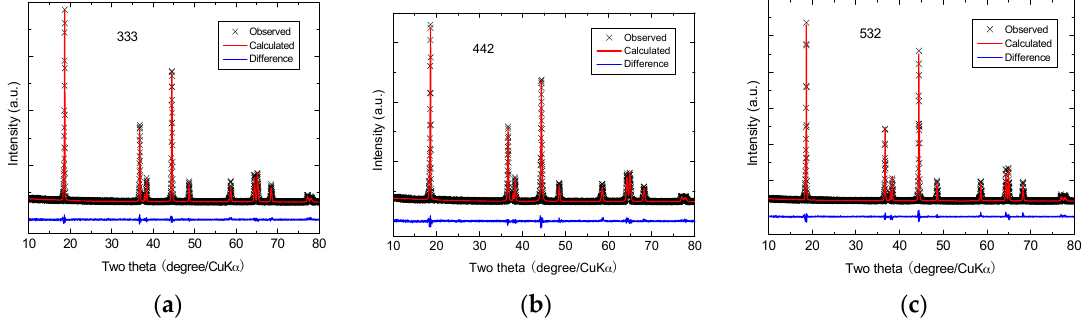
Figure 6. Rietveld refinement patterns of NMC samples: ( a ) 333; ( b ) 442; ( c ) 532 synthesized by solid-state reaction. The cross marks show observed XRD intensities and the solid line (red) represents calculated intensities. The curve at the bottom (blue) is the difference between the calculated and observed intensities on the same scale.